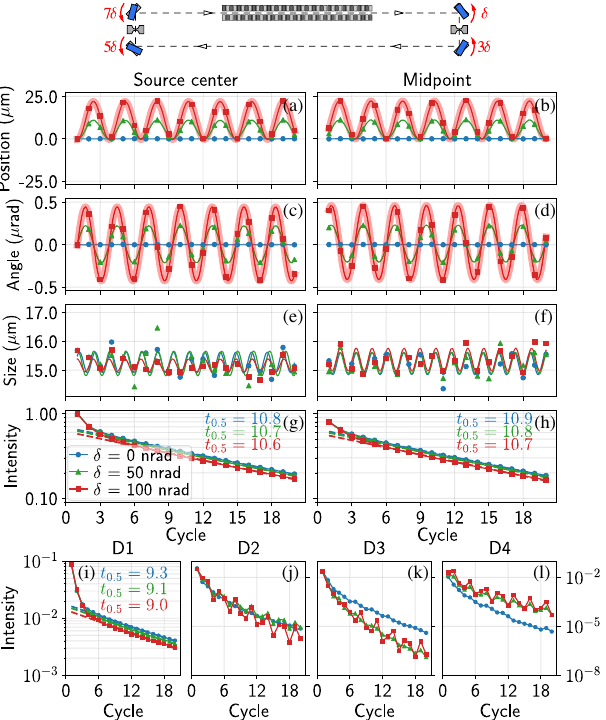
FIG. 14. Similar to Fig. 13, but with yaw angle error δ in crystal C 4 .